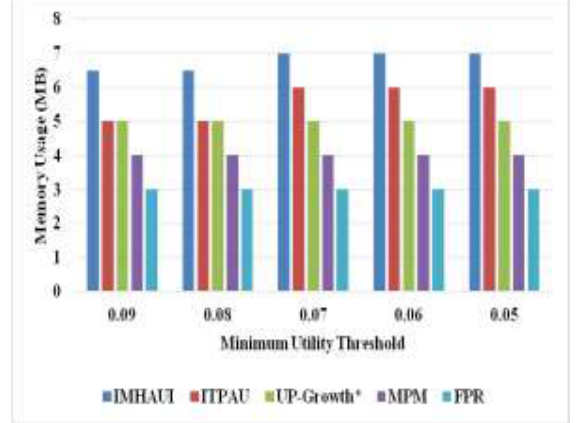
Figure 12. Accidents Memory Usage